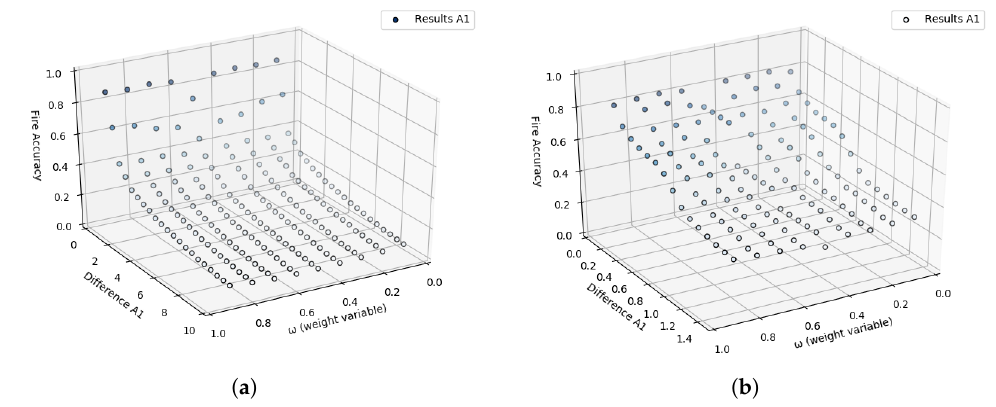
Figure 12. Graph visually demonstrating the result of the A 1 approach with the mentioned intervals for D and ω from 0 to 1.0 stepping 0.1. ( a ) A 1’s results with D range 0 to 10 stepping 1. ( b ) A 1’s results with D range 0 to 1.5 stepping 0.1.